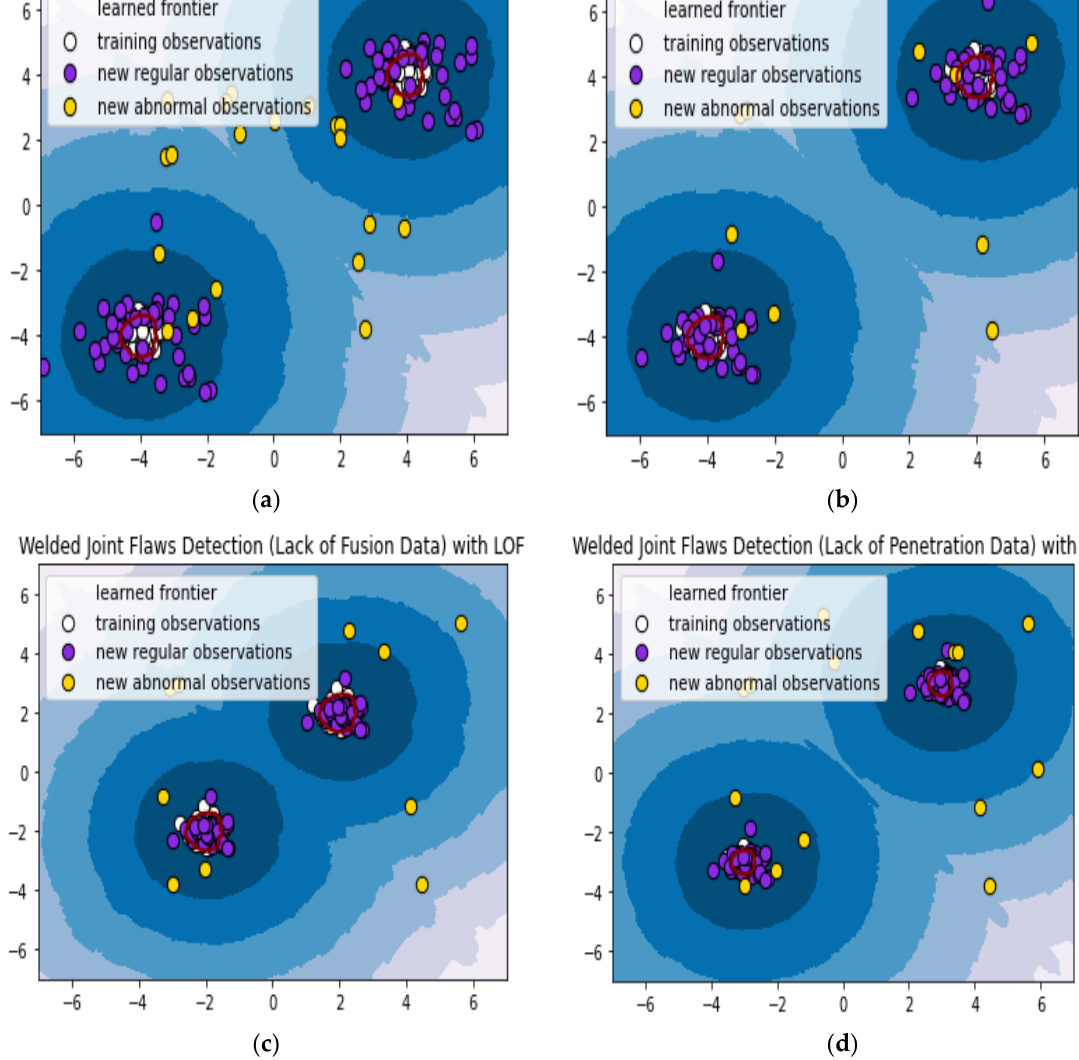
Figure 4. Detection of flaws due to internal crack, internal porosity, internal fusion, and internal penetration in the welded joint.